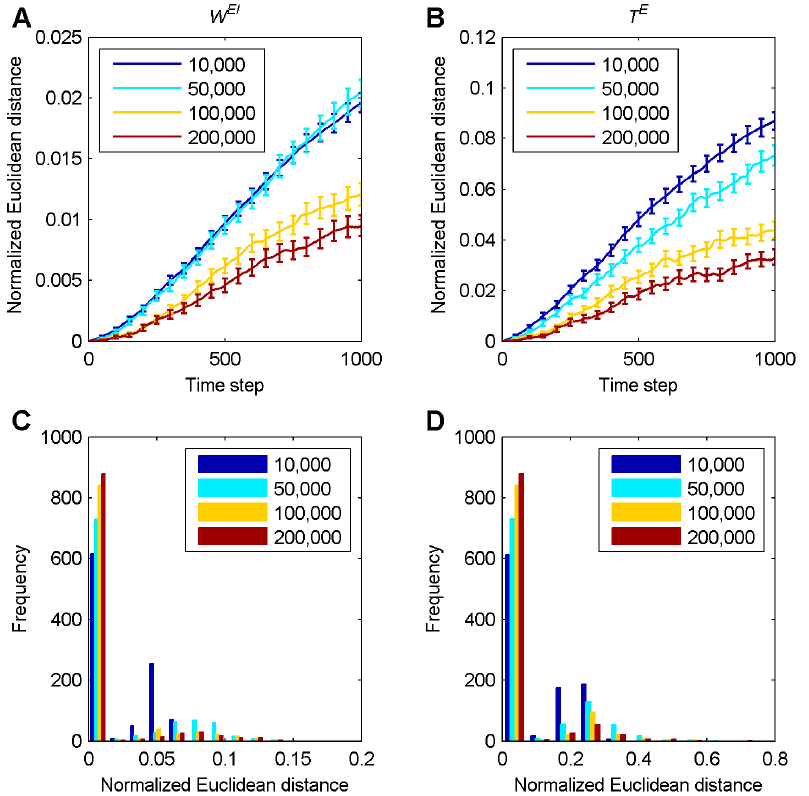
Figure 5. Long term development of normalized Euclidean distances between inhibitory-to-excitatory weight matrices and excitatory threshold vectors. The color indicates the starting time of the perturbations as shown in the legend. A Averaged normalized Euclidean distance between inhibitory-to-excitatory weight matrices over 1,000 simulations for 1,000 time steps. B Averaged normalized Euclidean distance between excitatory threshold vectors over 1,000 simulations for 1,000 time steps. Errorbars indicate standard errors of the mean in A and B. C Histogram of normalized Euclidean distances at 1,000th time step in A. D Histogram of normalized Euclidean distances at 1,000th time step in B. Fig. 4 D , E show the average i , d , and c for the four Fig. 4 A – C show histograms of i , d and c at different stages of different stages of network evolution. i , d and c are network evolution. The majority of perturbations produce a significantly different from zero across all phases (except negative value of